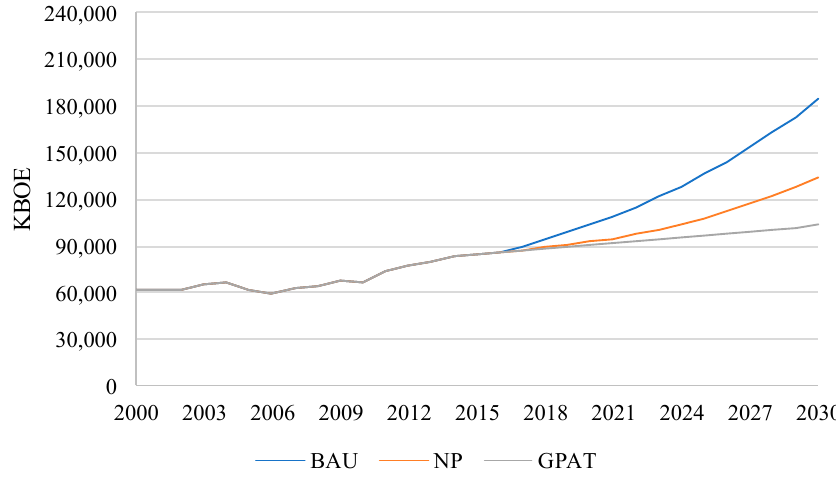
Figure 3. Energy demand, Business as Usual (BAU), National Policies (NP) and Global Policies and Trends (GPAT) scenarios for 2030.